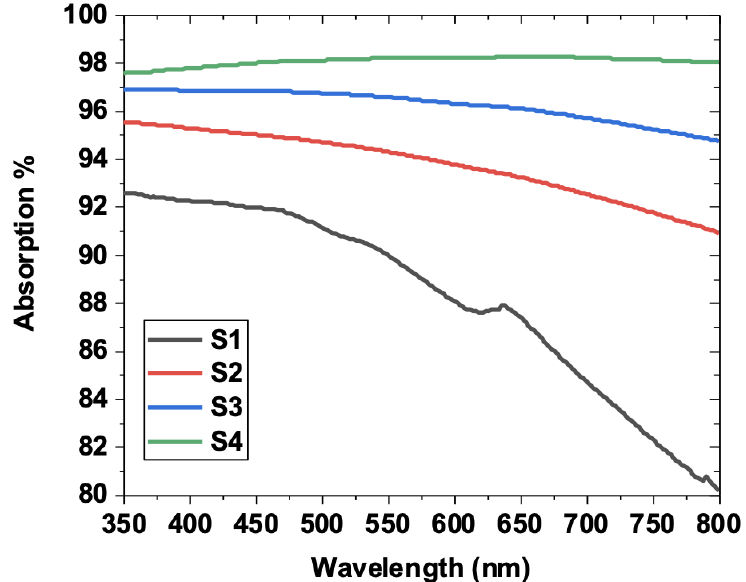
Figure 10. Optical absorption for the four considered samples. Note excitons position at 620 nm. As can be seen, samples S1, S2, and S3 exhibited similar optical behavior, consisting of a steady decrease in the optical absorption, which started at 93 – 97% and hit 80% for S1.